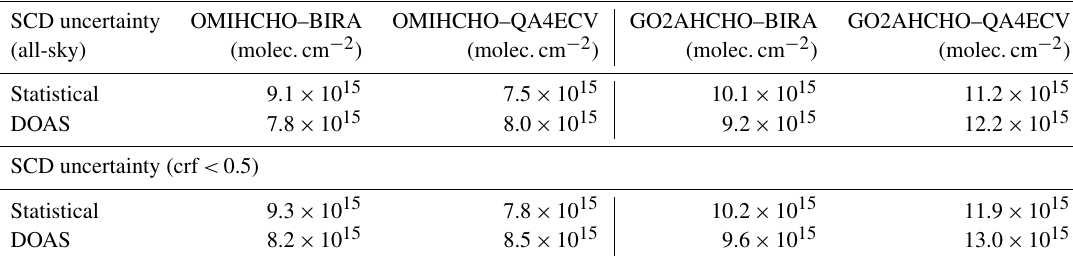
Table 5. Statistical and DOAS uncertainty estimates of OMI and GOME-2A HCHO SCDs for OMIHCHO–BIRA and OMIHCHO– QA4ECV (Pacific orbit from day 1 of January, April, July, and October (or closest available data) 2005–2015), and GO2AHCHO–BIRA and GO2AHCHO–QA4ECV (Pacific orbit from day 1 of January up to December and from day 15 of January, April, July, and October (or closest available data) 2007–June 2014 and 2007–2015 respectively) for all-sky conditions (top panel) and clear-sky conditions (bottom panel). The GO2AHCHO–BIRA data are provided only for scenes with cloud fraction lower than 0.4; therefore the clear-sky conditions yield similar SCD uncertainties to the all-sky conditions. Cloud radiance fraction values are typically larger than cloud fraction values; therefore SCD uncertainties for clear-sky conditions are still slightly larger than the all-sky